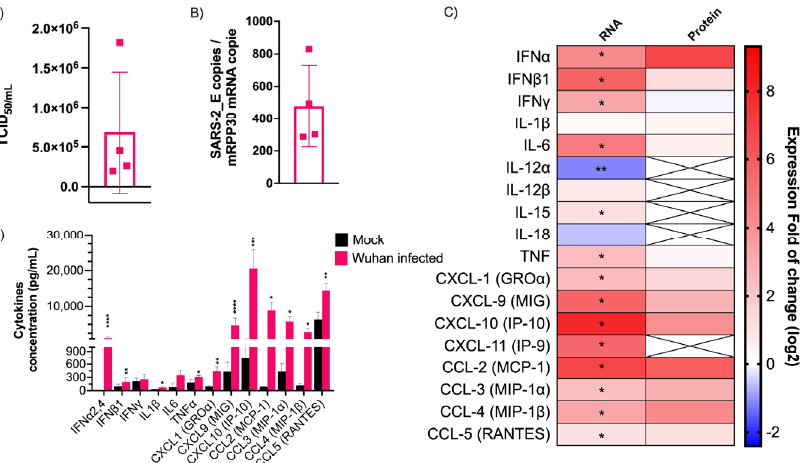
Figure 1. Cytokine mRNA and protein expression profile following infection of K18-ACE2 mice with Wuhan strain. Infected or mock mouse lung tissues were collected three days post-infection ( n = 4/group). ( A ) The SARS-CoV-2 E gene copy number was evaluated by ddPCR using lung RNA and expressed as number per copy of Rpp30 mRNA (mean ± SD). ( B ) Infectious viral titers were determined in lung homogenates and expressed in TCID 50/mL (mean ± SD). ( C ) Gene expression was evaluated by RT-qPCR and cytokine concentration in lung homogenates determined using a 13-plex Luminex panel. Cytokine gene expression and concentration levels are presented as heatmaps with results expressed as fold (log 2 ) relative to mock-infected mice (mean). Statistical analyses were performed by comparing 2 ( −Δ Ct) values for each gene in the control group and infected groups with a nonparametric T-test. ( D ) Cytokine concentrations in lung homogenates. Results are expressed as mean ± SD. For protein quantification, statistical analyses were performed by comparing the normalized concentration for each cytokine in the control group and infected groups with a nonparametric t -test. * p < 0.05, ** p < 0.01, *** p < 0.001, **** p < 0.0001.